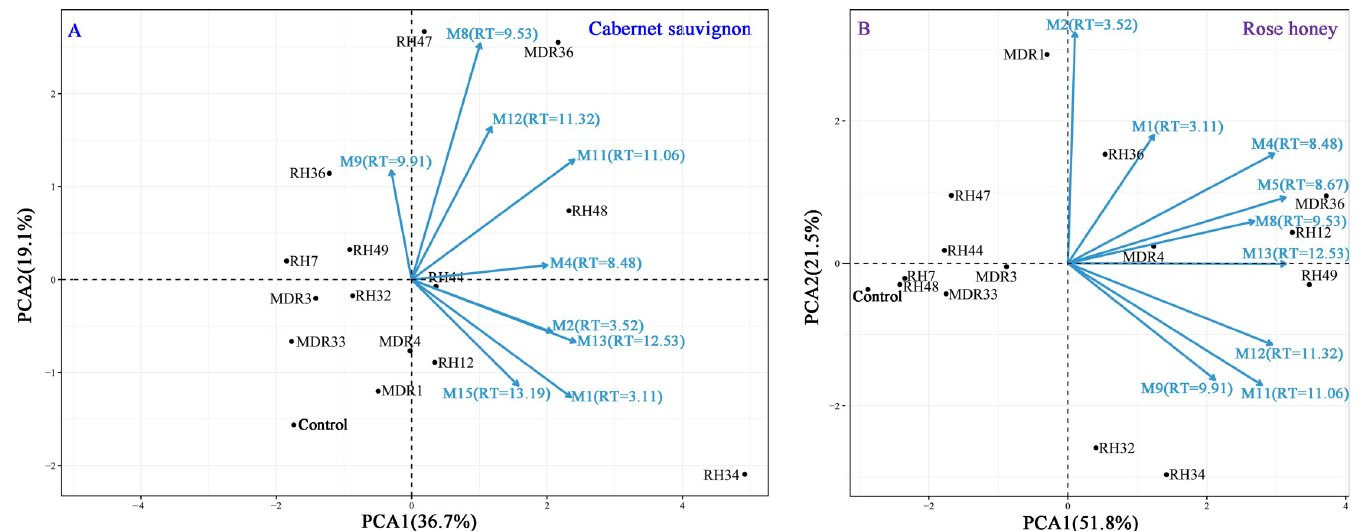
Fig 5. PCA of the impact of endophytic fungal infection on codetected metabolites in CS and RH leaves.